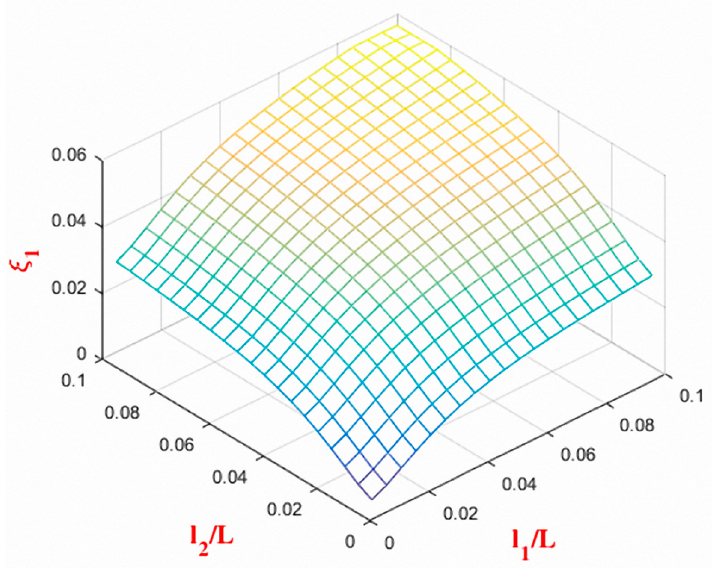
Figure 12. Installation positions optimization for two HDR dampers.